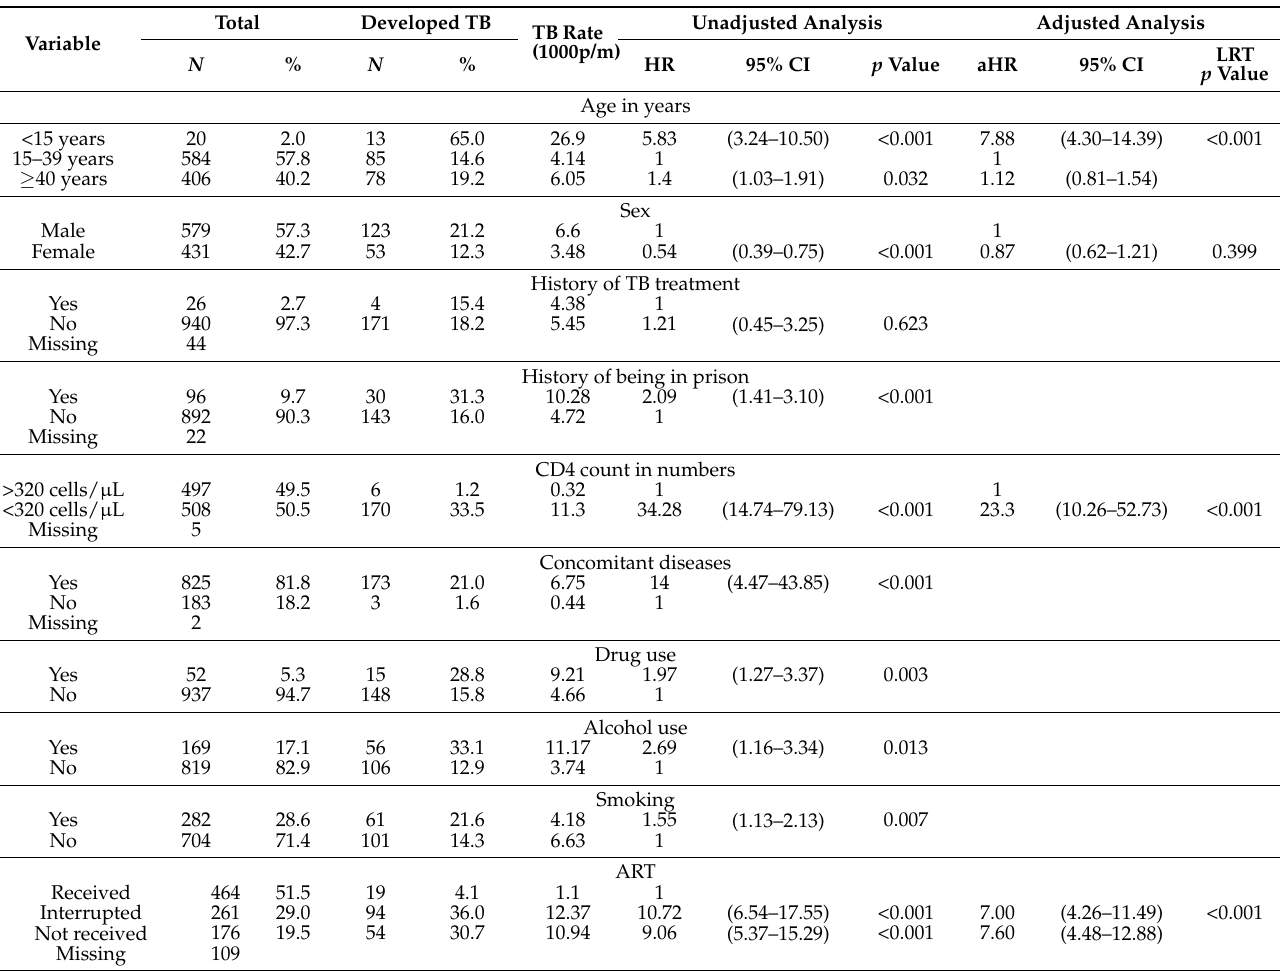
Table 1. Factors associated with TB development among people newly diagnosed with HIV from 2015 to 2017, Tashkent,